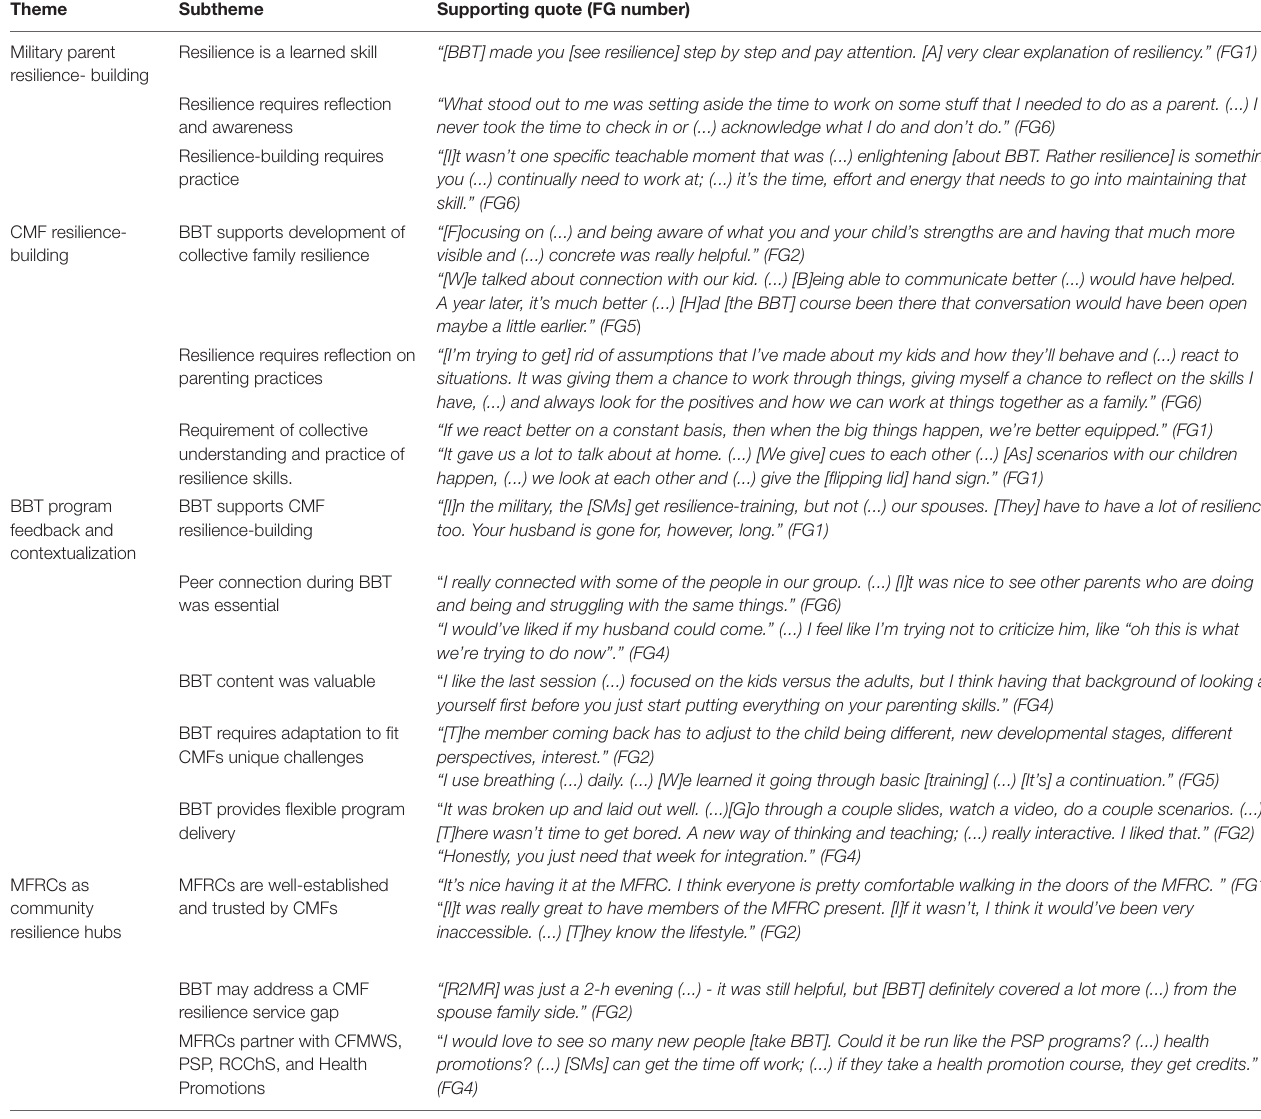
TABLE 3 | Major themes and